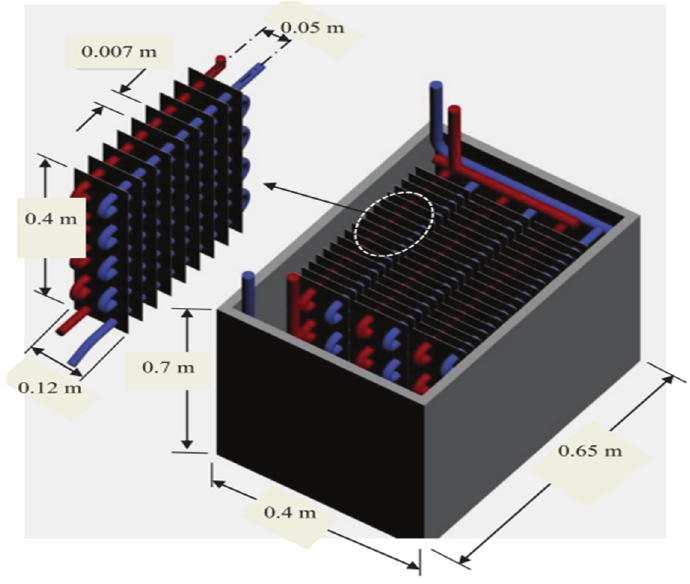
Figure 17. Shell-and-finned tube heat exchanger designed in [53].